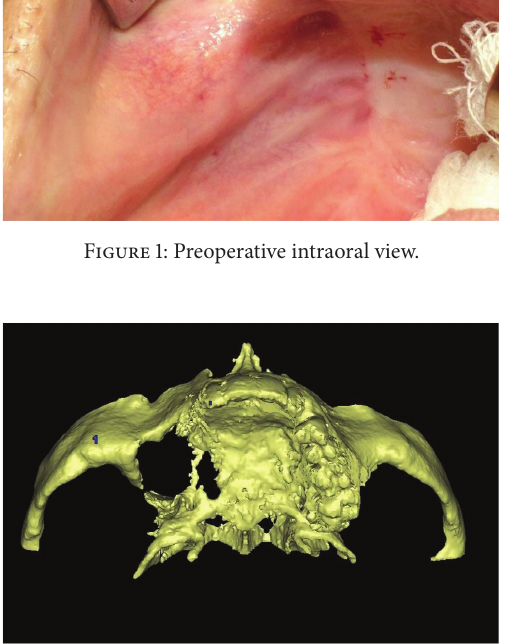
Figure 2: 3D view of defect.